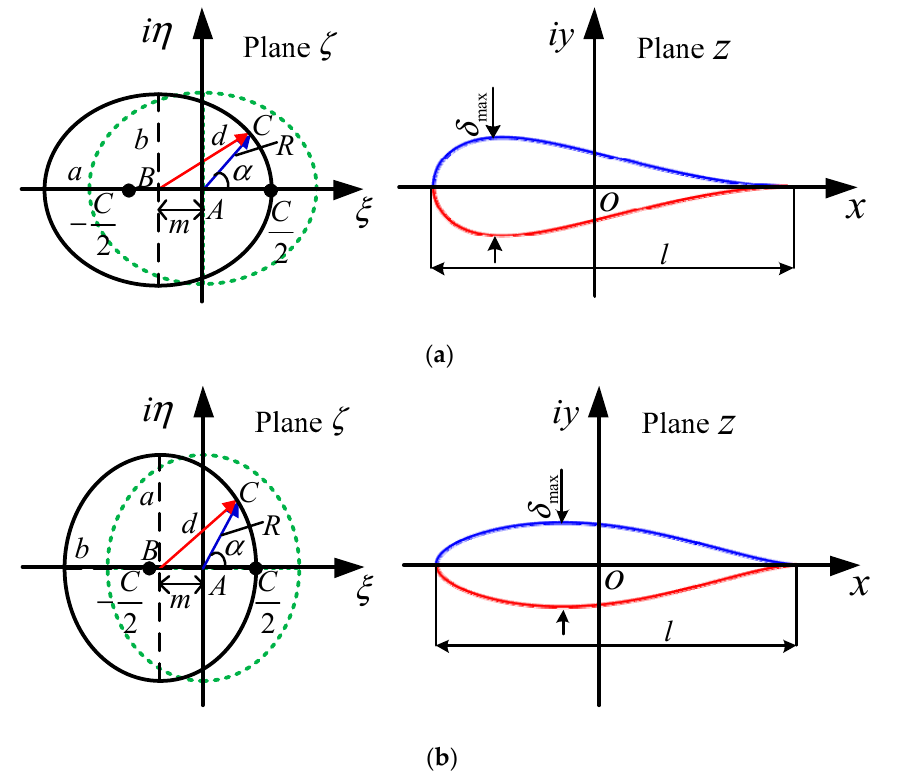
ζ Figure 3. Ellipse transformation model. The ellipse is moved a certain distance along the real axis, and the airfoil with a var- iable relative thickness position is obtained by the Joukowski transformation. The rela- tionship between the major axis and the minor axis of the ellipse determines whether the relative thickness position is close to the leading edge or the trailing edge. Thus, a sym- metric airfoil with different relative thickness positions can be obtained by moving the rotating ellipse for a certain distance along the imaginary axis, and the airfoil with a vari- able relative camber position can be obtained through the Joukowski transformation. The size of the major axis determines the relative camber position of the airfoil. The trans- formed airfoil parameter equations are added to obtain the variable relative camber posi- tion and the airfoil parameter equation with the variable relative thickness position. 3.1. Determination of Relative Thickness Position As shown in Figure 4a, the parametric equation of the ellipse at the coordinate origin ( A ) on the plane ζ is as follows: